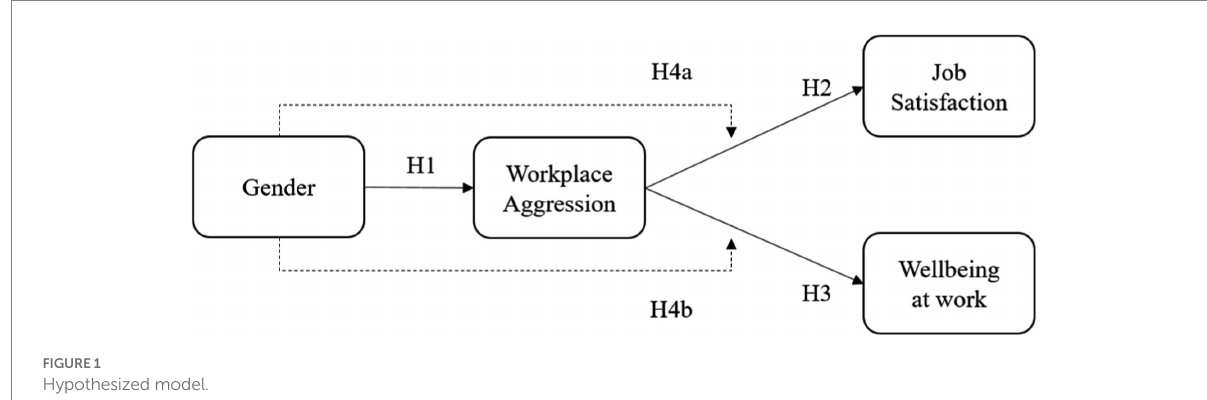
FIGURE 1 Hypothesized model.